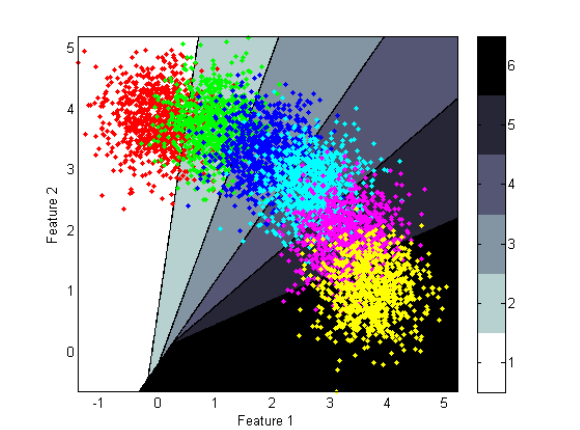
Figure 8: Decision boundaries of the Linear Ordinal SVM clas- sification model for the simulated data set. The overlapping dis- criminant functions are combined by a decision tree for an unam- biguous result.